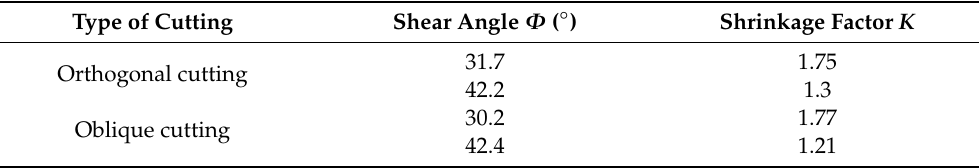
Table 7. Shrinkage factor K achieved within the experimental